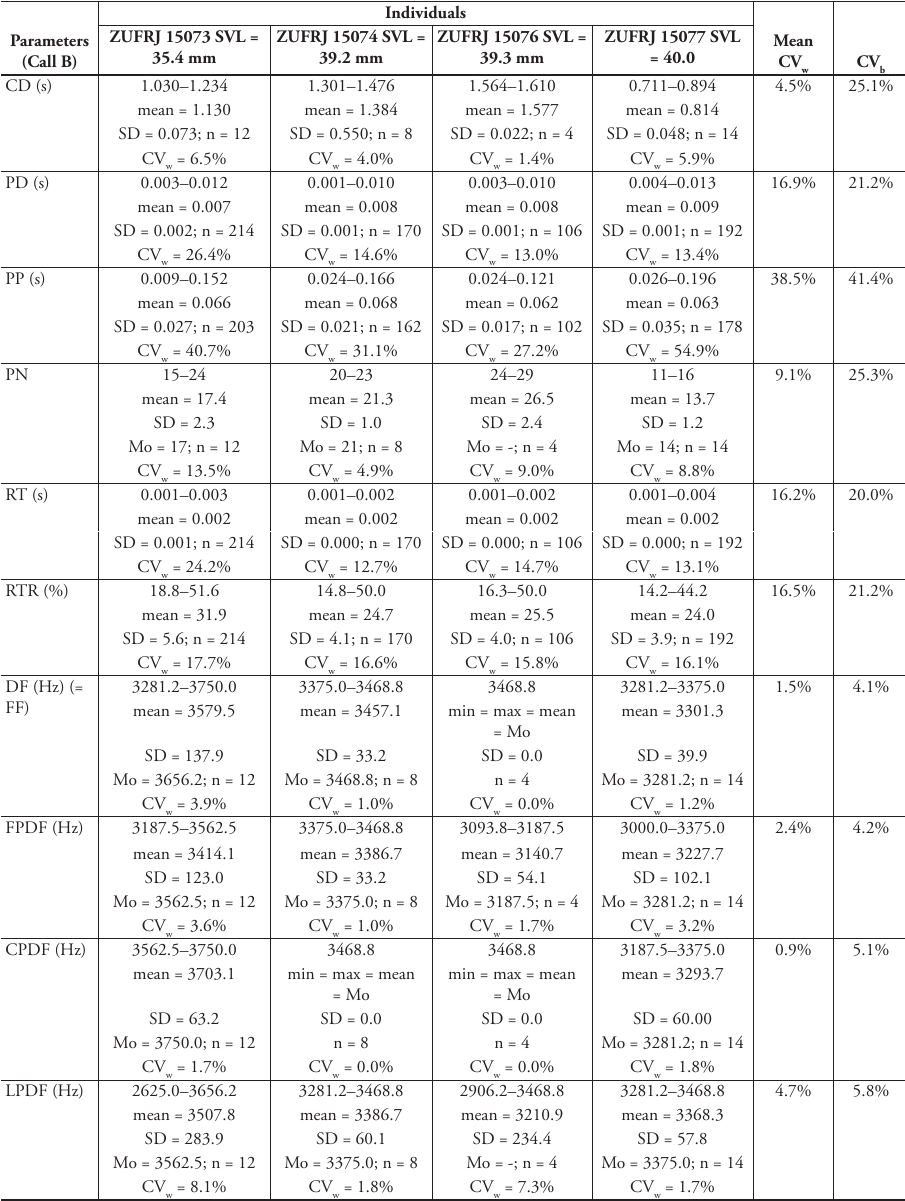
Table 2. Call parameters for the call B of each recorded individual of Boana latistriata . Values are given as range, mean, standard deviation (SD), mode (Mo; when applicable) and sample number (n). Abbreviations: SVL, snout-vent length; CV , within-individual coefficient of variation; CV , between-individual coefficient w b of variation; CD, call duration; DF, dominant frequency; FF, fundamental frequency; PD, pulse duration; PP, pulse period; RT, pulse rise time; RTR, proportion of pulse rise time in relation to pulse duration; FPDF, first pulse dominant frequency; CPDF, central pulse dominant frequency; LPDF, last pulse dominant frequency; PN, pulse number. Mode followed by an “-“ indicates that no value was more frequent than the